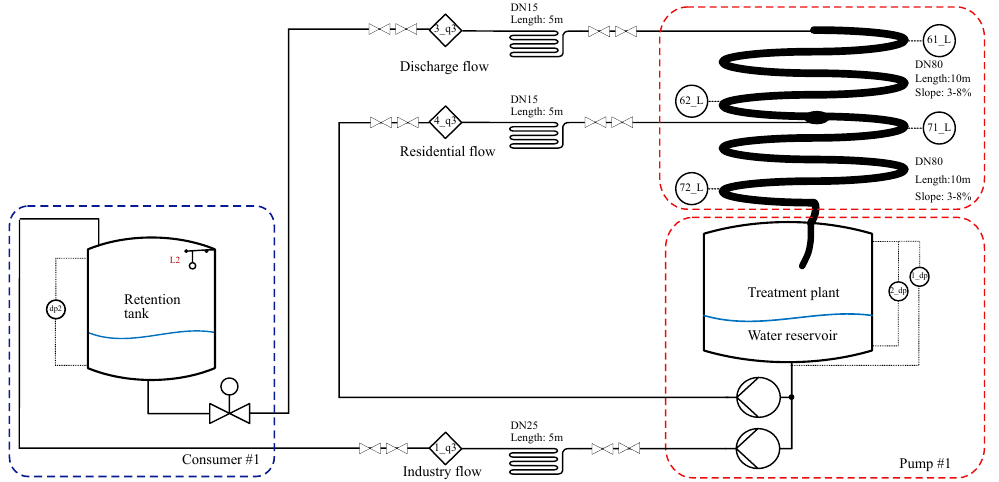
Figure 18. Diagram of the emulated waste water collection at the SWIL.